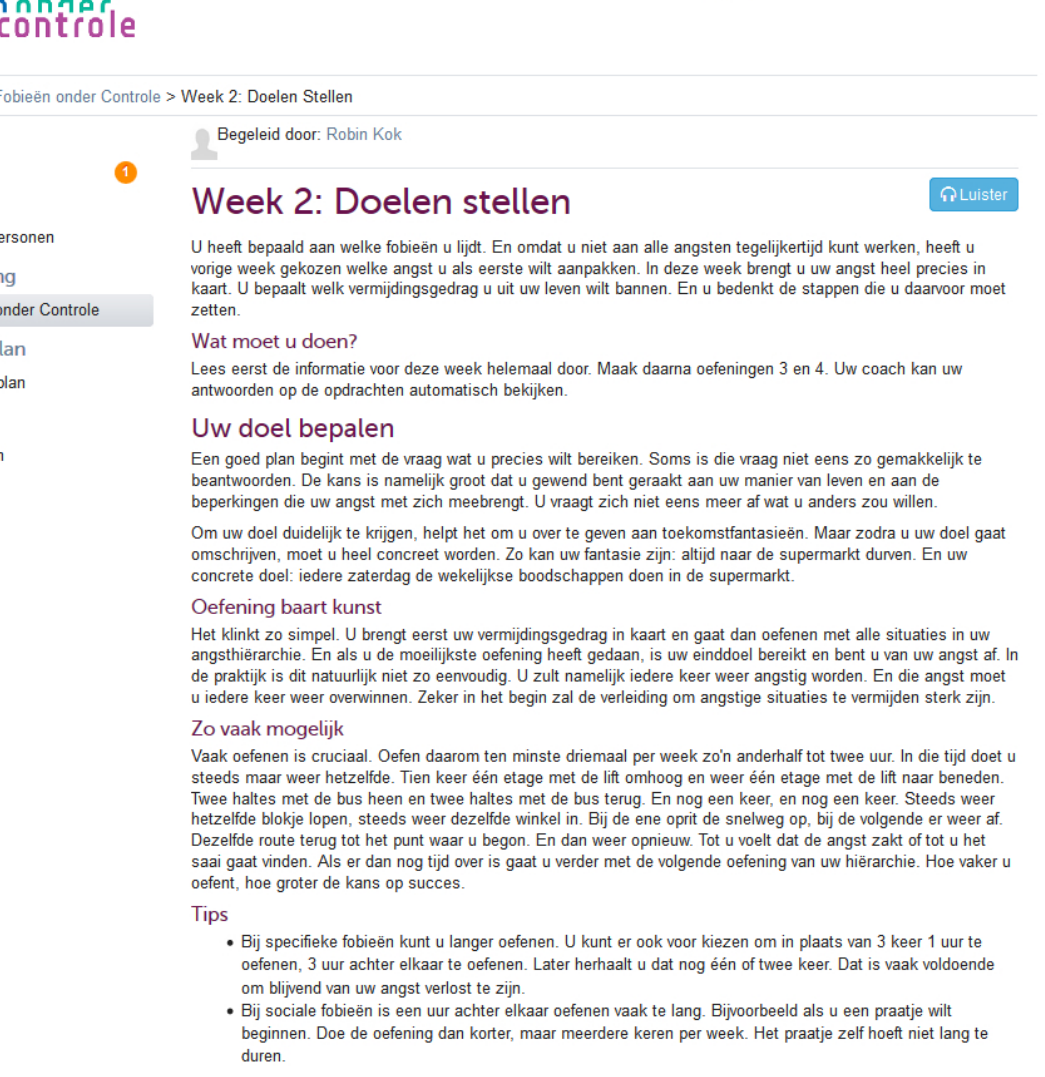
Figure 2. Screenshot of Phobias Under Control: intervention